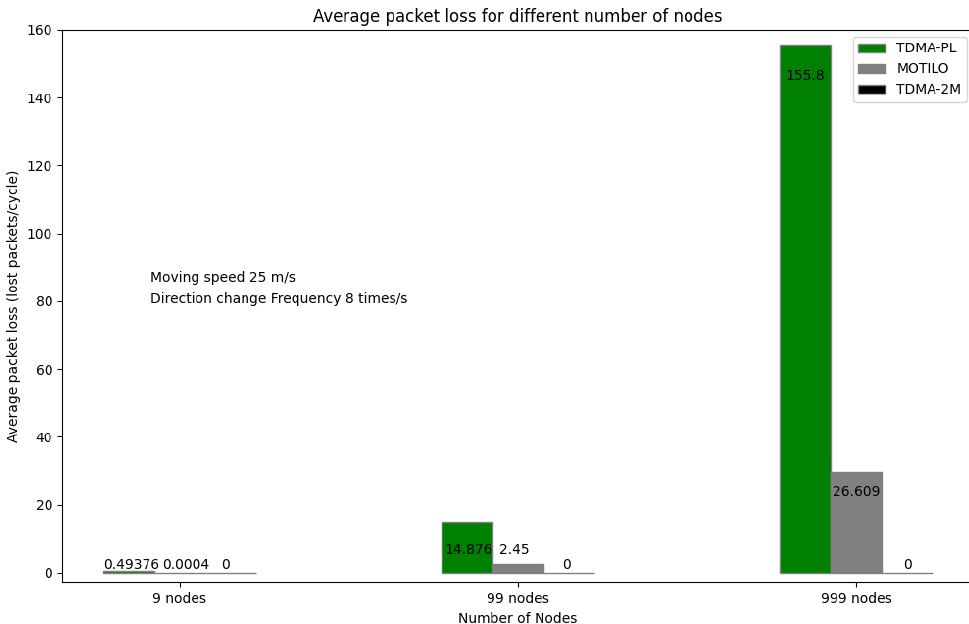
Figure 6. Average packet loss under TDMA-PL, TDMA-2M and MOTILO